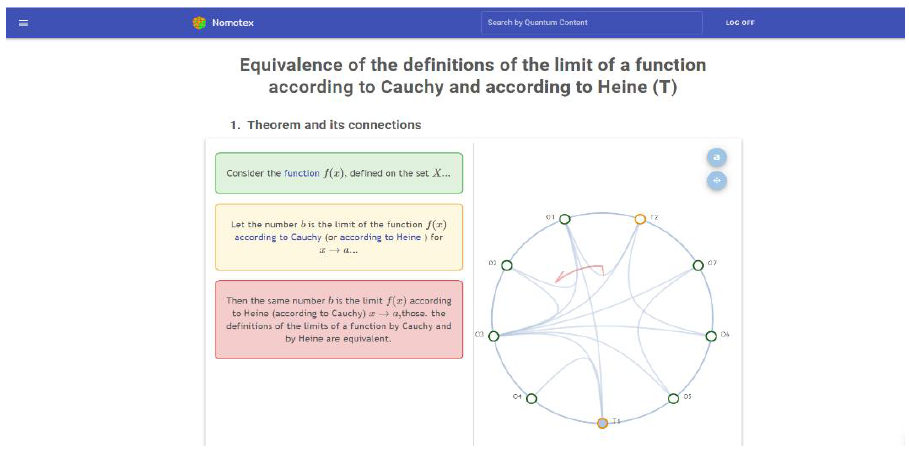
Fig. 3. Window of the «Implementation of neural network programs"» subsystem in the Nomotex DLS. Course «Mathematical analysis», paragraph «The concept of the limit of a function», lecture 8, quantum Equivalence of definitions according to Cauchy and Heine. Traffic